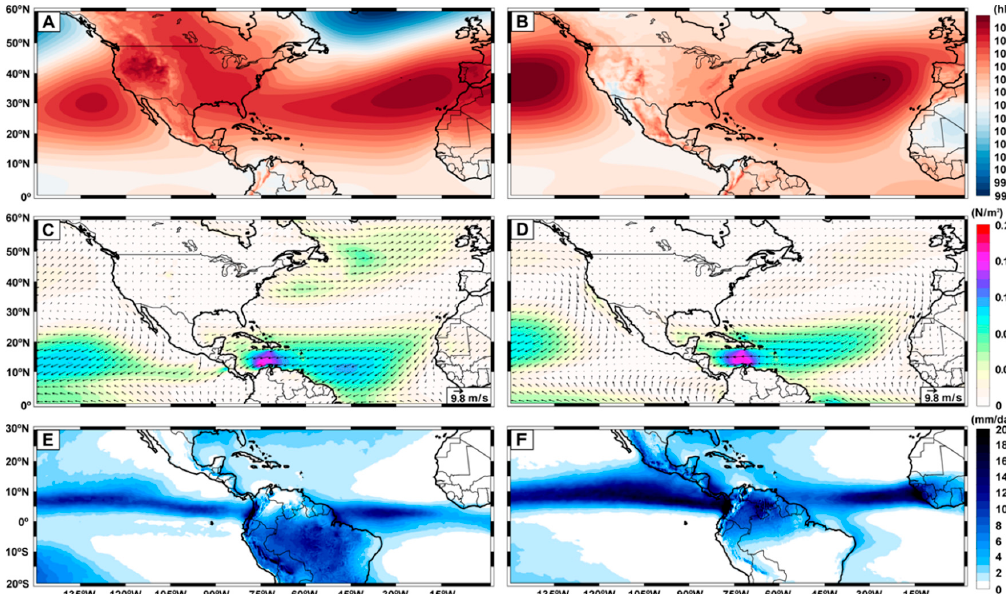
Figure 1. Mean Sea–Level Pressure for ( A ) DJF and ( B ) JJA. 10 m wind vectors and zonal wind shear (shaded) for ( C ) DJF and ( D ) JJA and average rainfall for (C) January and (D) July respectively, for the 1979–2019 period based on fifth generation of the European Centre for Medium–Range Weather Forecasts atmospheric reanalyses of the global climate (ERA5) data. Both (A) and (B) show the contrasting seasonal expansion of the North Atlantic Subtropical High (NASH) western ridge. Surface winds show the coherence of the large–scale circulation with the pressure patterns and the area that features the Caribbean Low–Level Jet (CLLJ) is observed as a maximum of zonal wind shear. Complimentary ( E ) and ( F ) show the long–term average daily regional rainfall distribution. Based on this, the seasonal migration of the Inter–Tropical Convergence Zone (ITCZ) may be observed, including its effect over continental rainfall, contrasting drier conditions overland in January.